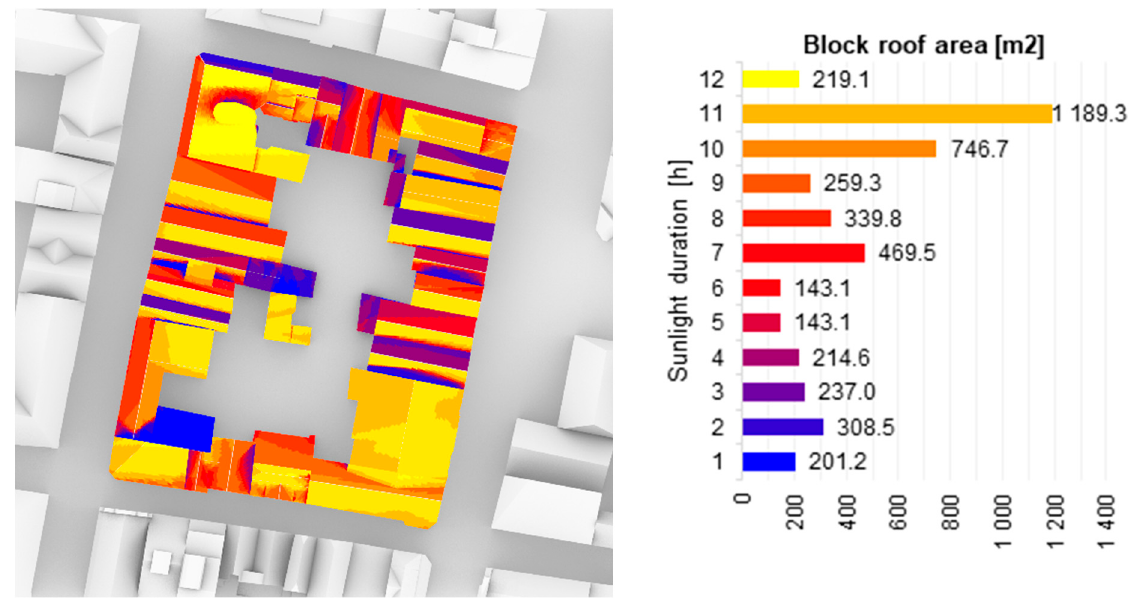
Figure 11. Surface area of roofs in particular periods of exposure to